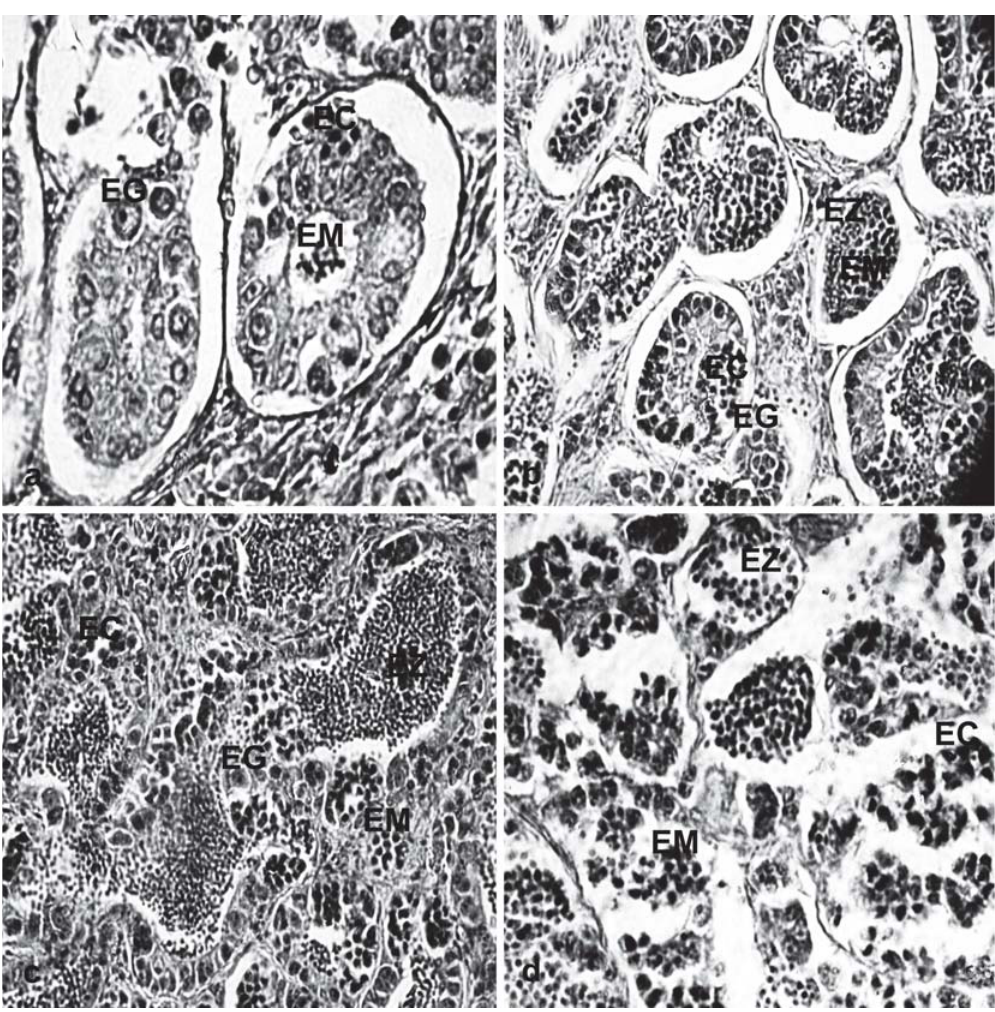
Fig. 2. Histologic sections of four different gonadal maturation stages of male Gymnotus aff. carapo . a) Immature (40 X); b) Maturing (40 X); c) Mature (40 X) d) Spent (40 X). EG: spermatogonia; EC: spermatocytes; EM: spermatids; EZ: